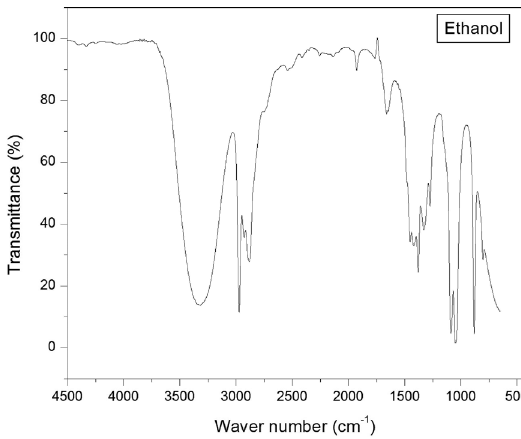
Figure 7. FTIR spectrum for the ethanol.